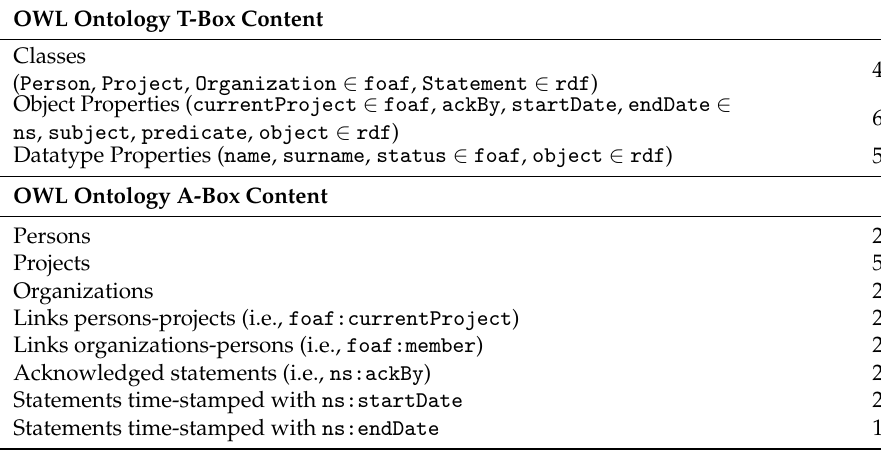
Table 2. Use Case #3: Summary of the Knowledge